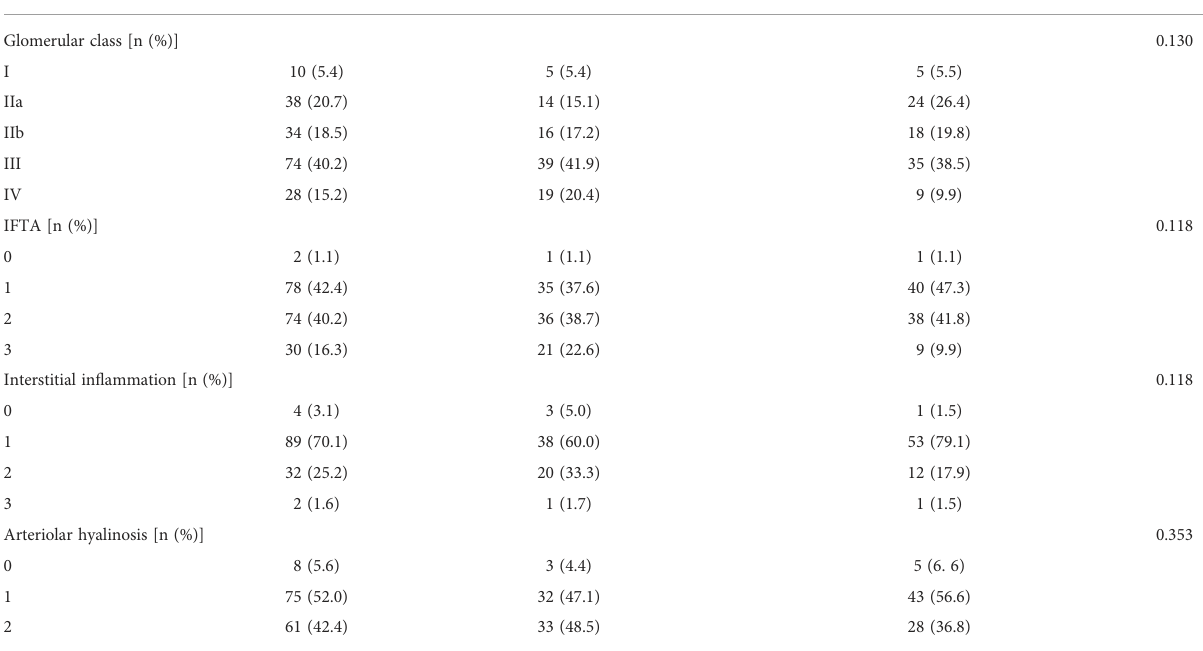
TABLE 2 Baseline pathologic features of 184 DKD